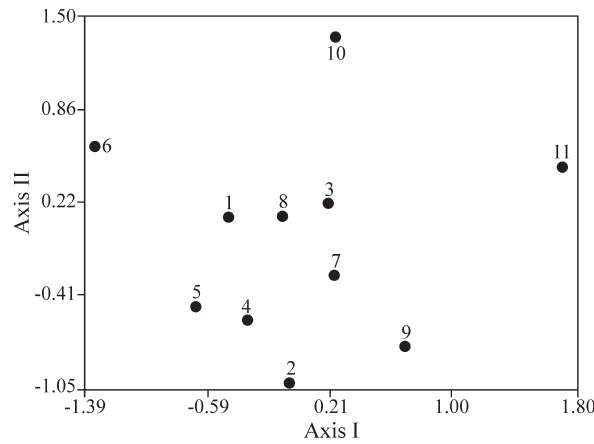
Figure 4 - Two-dimensional plot showing the relative position of the 11